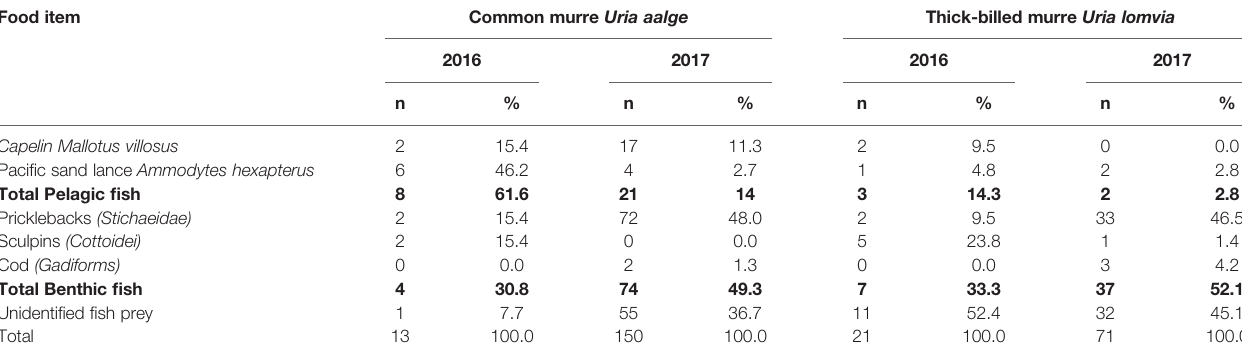
TABLE 3 | Food items delivered to the chicks by common and thick-billed murres at St. Lawrence Island in 2016 and 2017. Food item